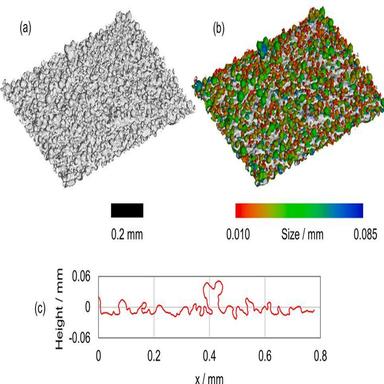
Example of Ti6Al4V surface topography extracted from CT data (a), feature-based characterization (b), and example of extracted surface profile (c).